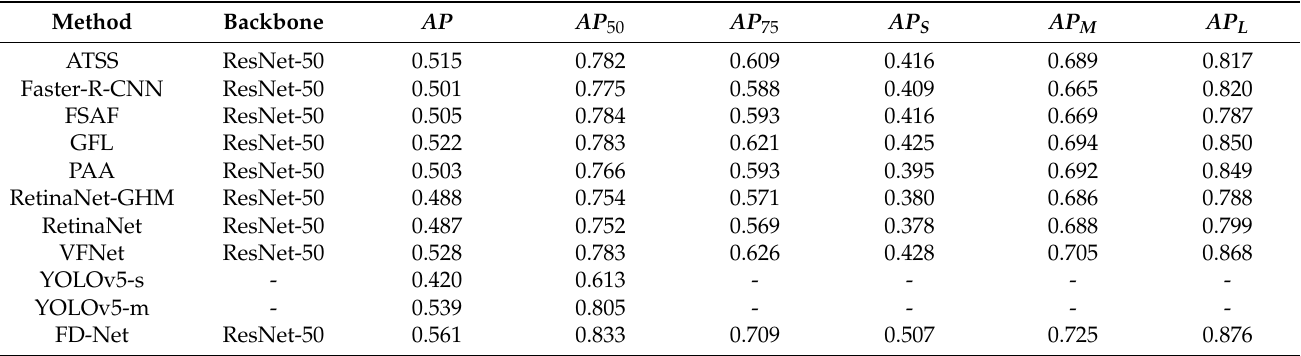
Table 4. Performance evaluation of different methods on the DIOR